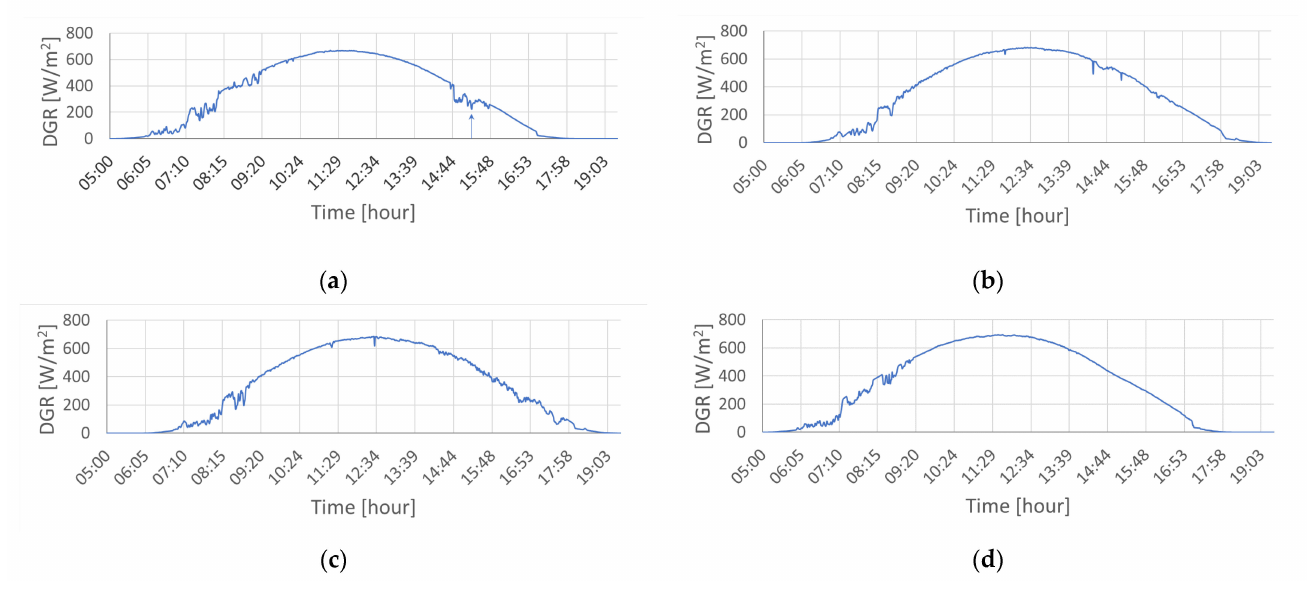
Figure 13. Daily Global Radiation—DGR ( a ) 21 March 2019 and ( b ) 2 April 2019 for system with active rotation, ( c ) 29 March 2019 and ( d ) 30 March 2019 for static system without rotation of thermal